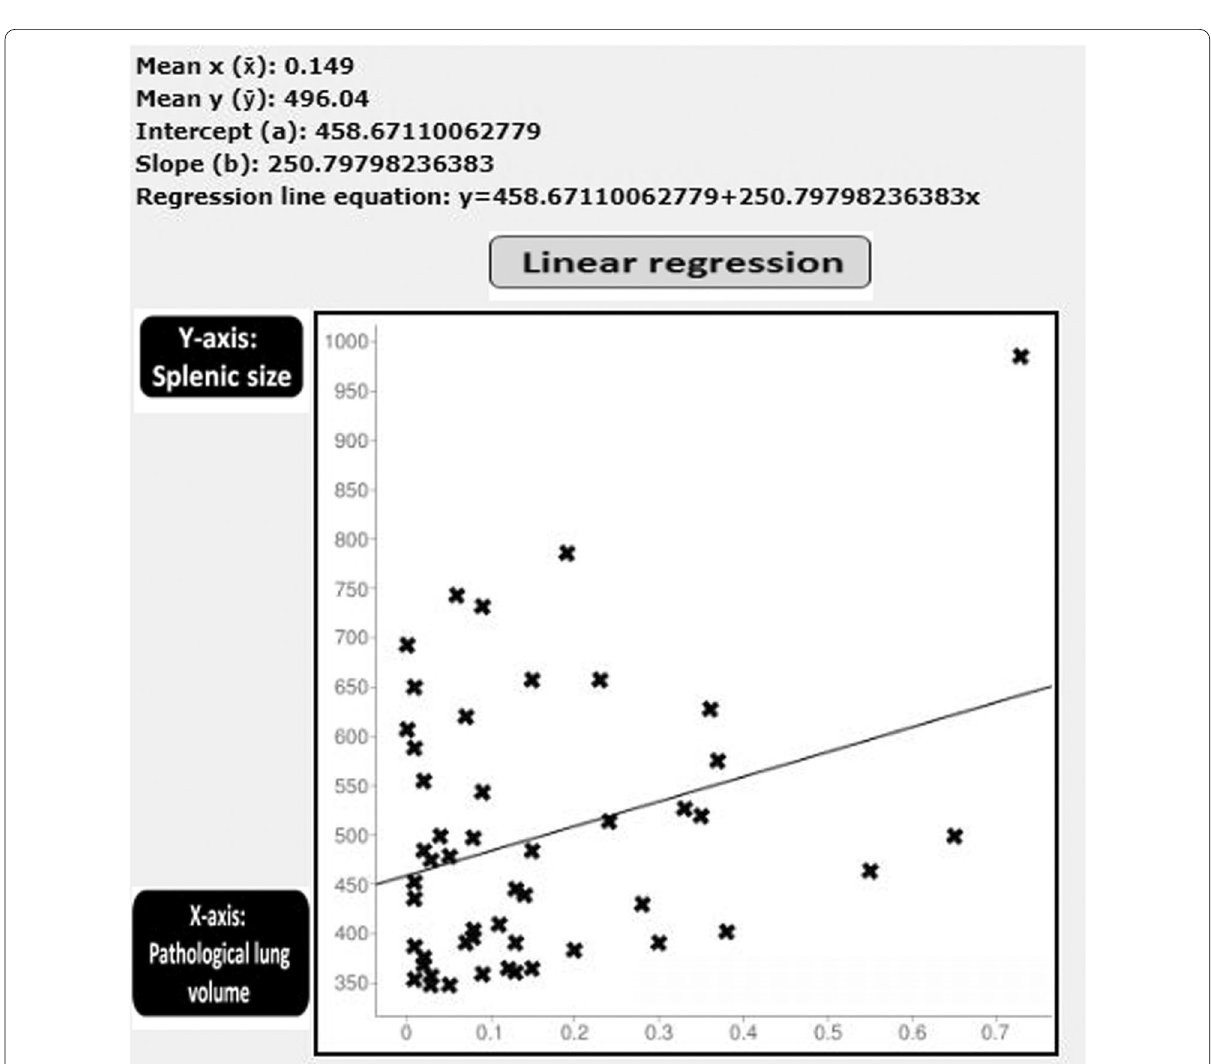
Fig. 6 Schematic presentation of Pearson correlation coefficient and linear regression analysis between the amount of pathological lung volume ( X -axis) and splenic size ( Y -axis): A positive (but weak) relationship was shown ( r